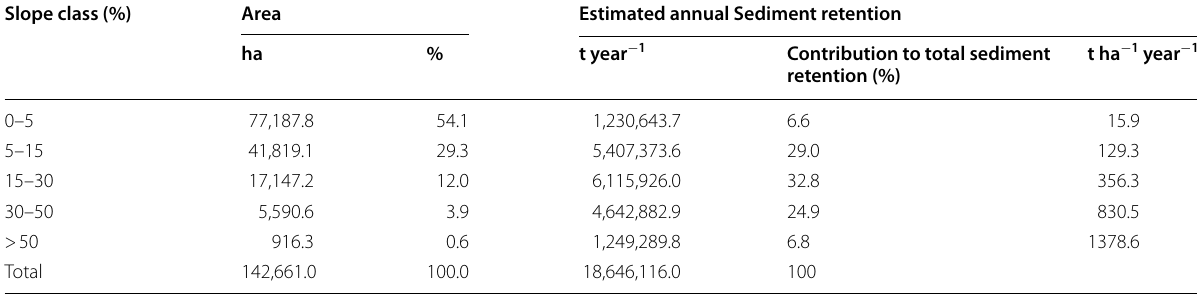
Table 8 Variation of annual sediment retention rates with slope classes Slope class